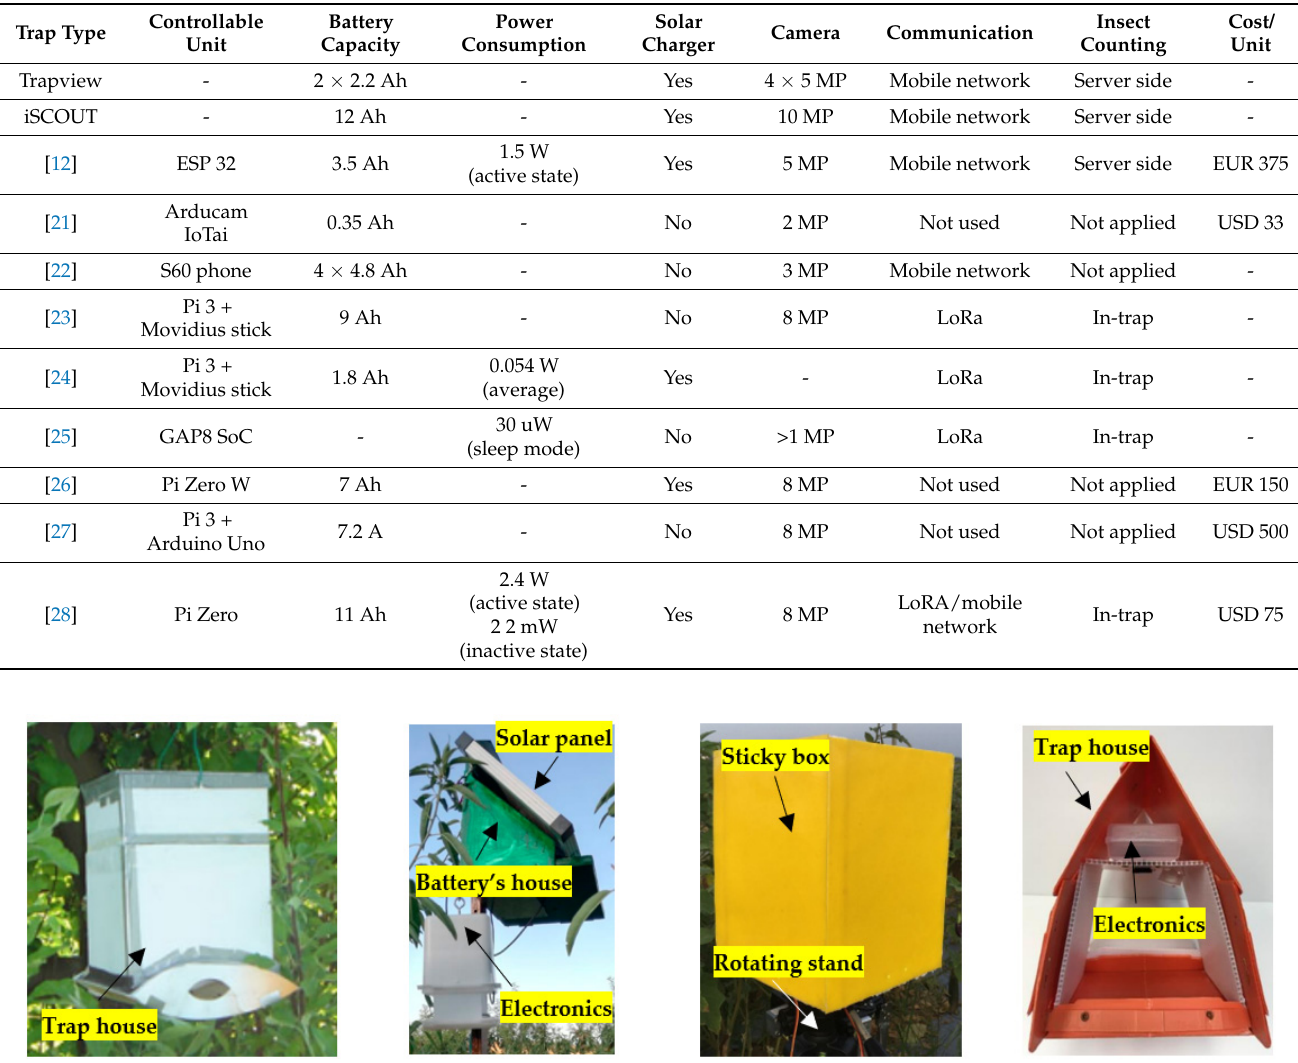
Table 1. Key features of automated traps. Empty cell means that the information is not available.